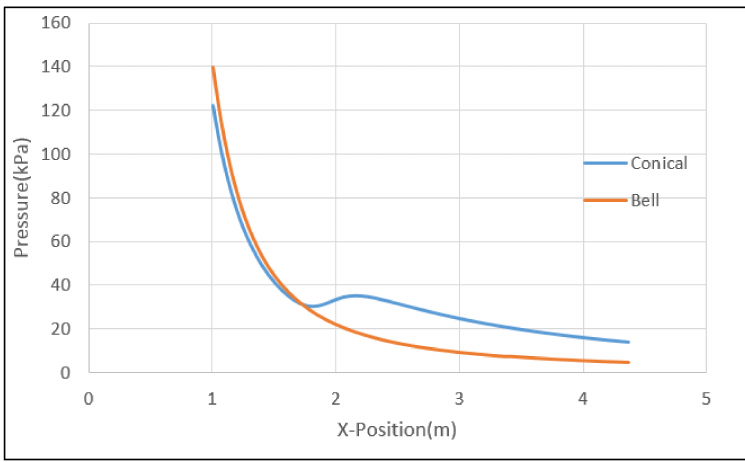
Figure 22. Mach contour for conical nozzle ( top ) vs. bell nozzle ( bottom ).